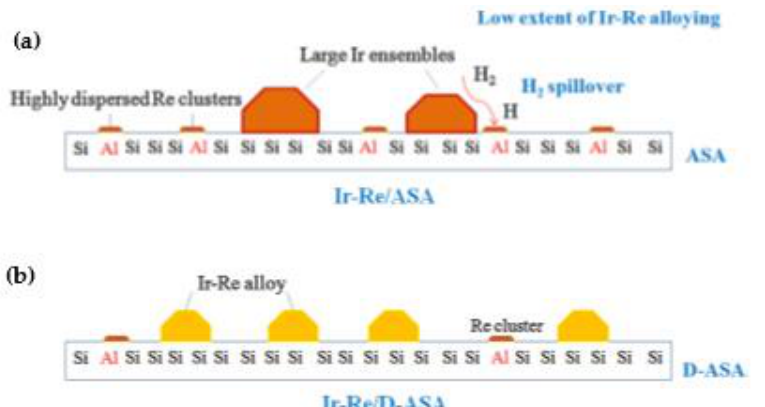
Figure 13. The formation of Ir and Ir – Re species on (a) SiO 2 – Al 2 O 3 (ASA) and (b) SiO 2 – Al 2 O 3 ( – Al) (D – ASA). Reproduced from [85] with permission from Elsevier.